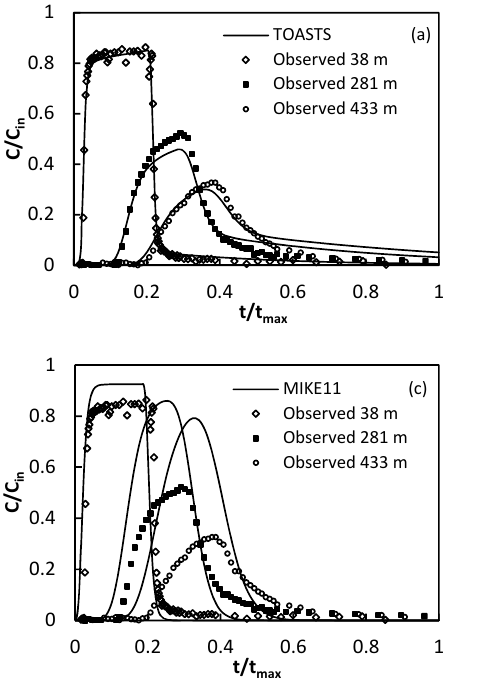
Figure 16. Observed and simulated strontium concentrations in the main channel (test case 4).